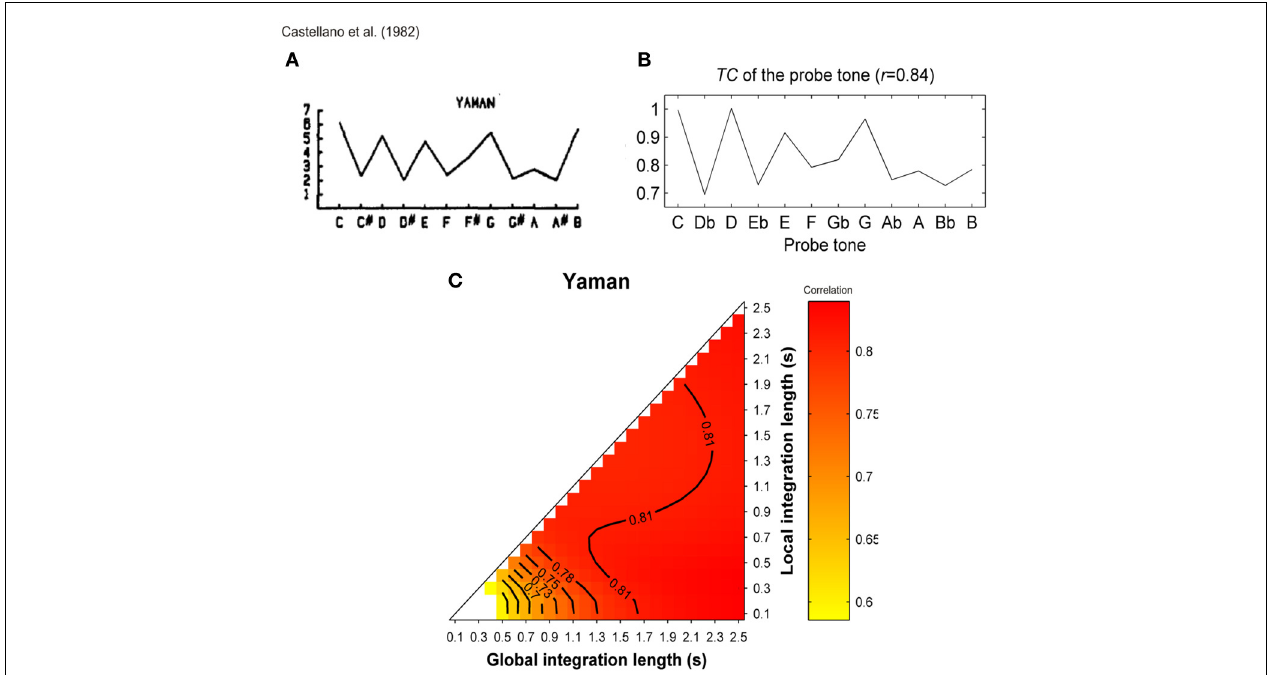
FIGURE 16 | Simulation of Castellano et al.’s (1984) study. Panel (A) reports the ratings profile obtained with the Yaman rag, averaged over Western and Indian listeners. Panel (B) shows the simulated tone profile, computed with a local and global context integration windows of 0.3 and 2.5s respectively. The correlation value between this simulated tone